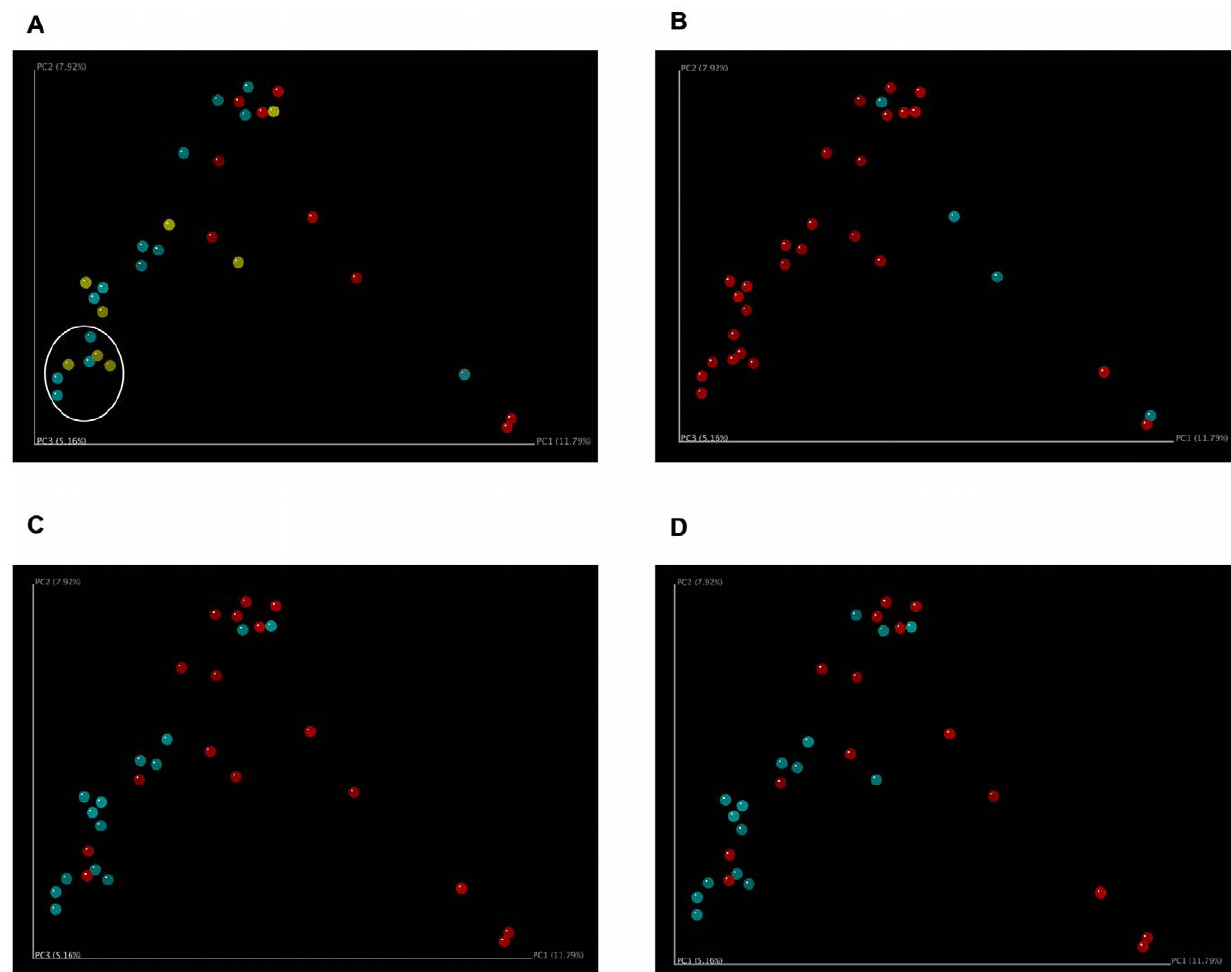
Figure 2. Principal Coordinate Analysis Demonstrates Clustering of COPD Samples, Inhaled Corticosteroid Users, and Inhaled Bronchodilator Users. Principal coordinate analysis was performed using mothur and Fast UniFrac, and the results for principal coordinates 1 and 2 are shown. A. Control, Moderate COPD, and Severe COPD. Control samples (red) cluster separately from Moderate COPD (blue) and Severe COPD (yellow) samples. Moderate and Severe COPD samples do not cluster separately. Seven COPD samples that separate the most from the control samples are circled and designated ‘‘left lower quadrant’’ (LLQ) samples for further analysis. B. Smokers and Non-Smokers. Smokers (blue) do not cluster separately from Non-Smokers (red). All of the COPD patients had been non-smokers for at least 6 months prior to bronchoscopy. C. Inhaled Corticosteroid Users and Non-Users. Inhaled corticosteroid users (blue, 14 of 22 COPD patients) are more likely to cluster near the intersection of principal coordinates 1 and 2 than non-users (red). D. Inhaled Bronchodilator Users and Non-Users. Inhaled bronchodilator users (blue, 16 of 22 COPD patients) are more likely to cluster near the intersection of principal coordinates 1 and 2 than non-users (red). All patients who received inhaled corticosteroids also received inhaled